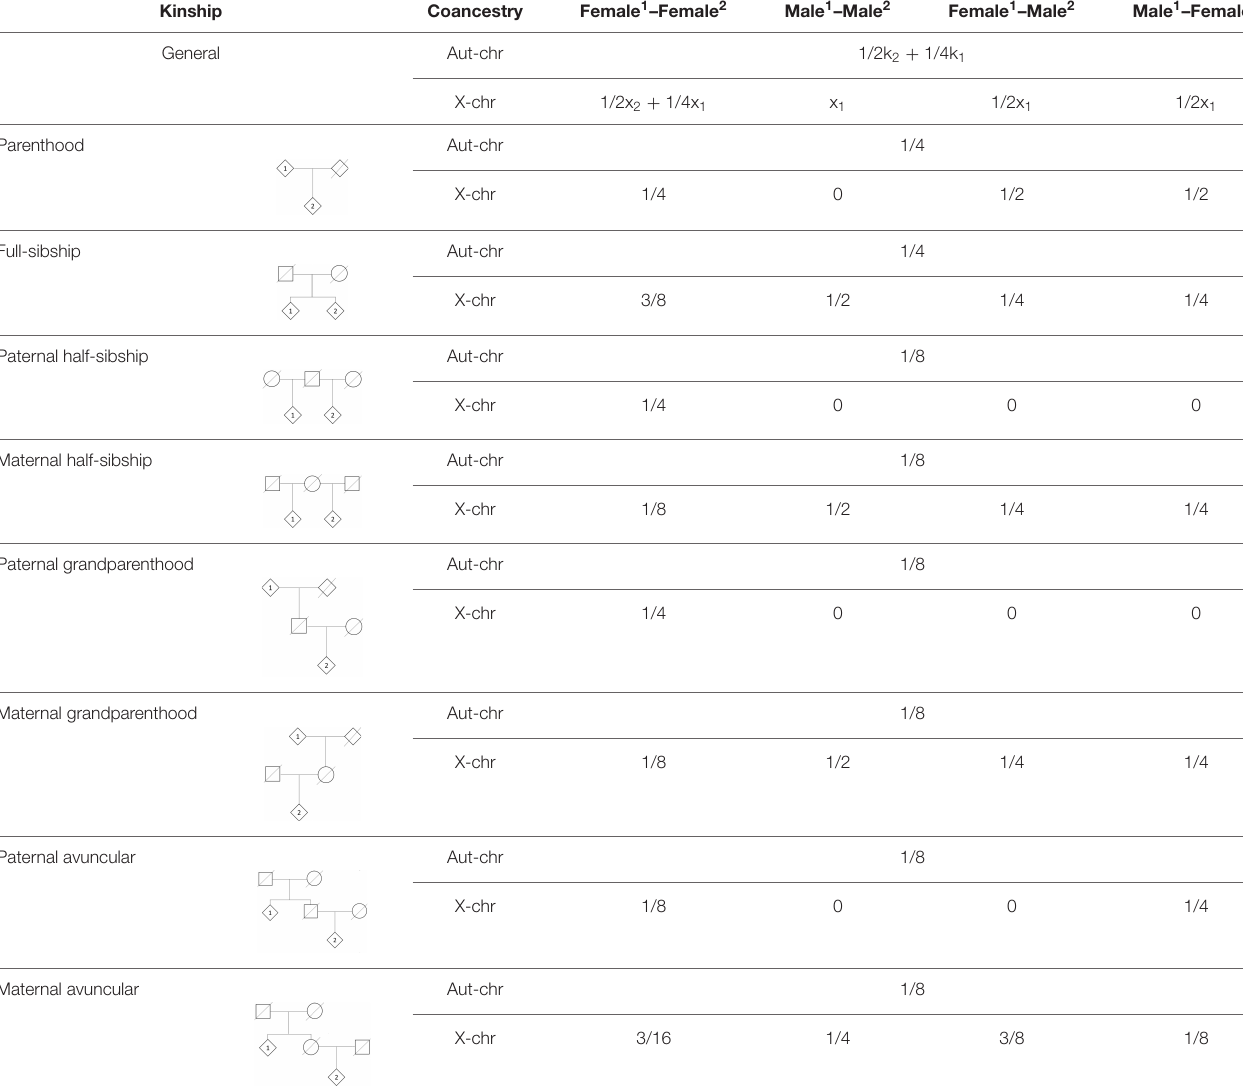
TABLE 5 | Probability of choosing a pair of identical-by-descent (IBD) alleles when one allele is randomly chosen from each individual. Numbers in superscript in header refer to the sex of the individuals represented in genealogies.